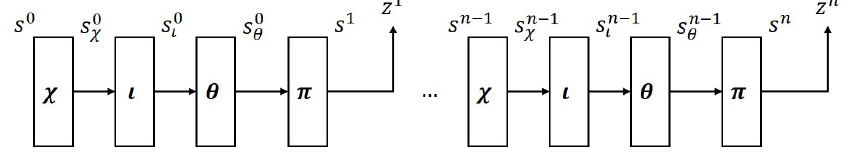
Figure 3: Equivalent description of processing the